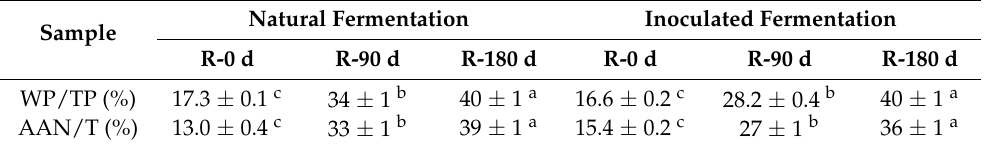
Table 2. The degree of hydrolysis of protein in natural and inoculated fermented